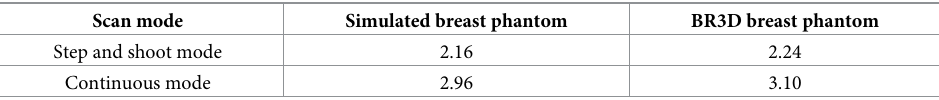
Table 4. β values of the anatomical